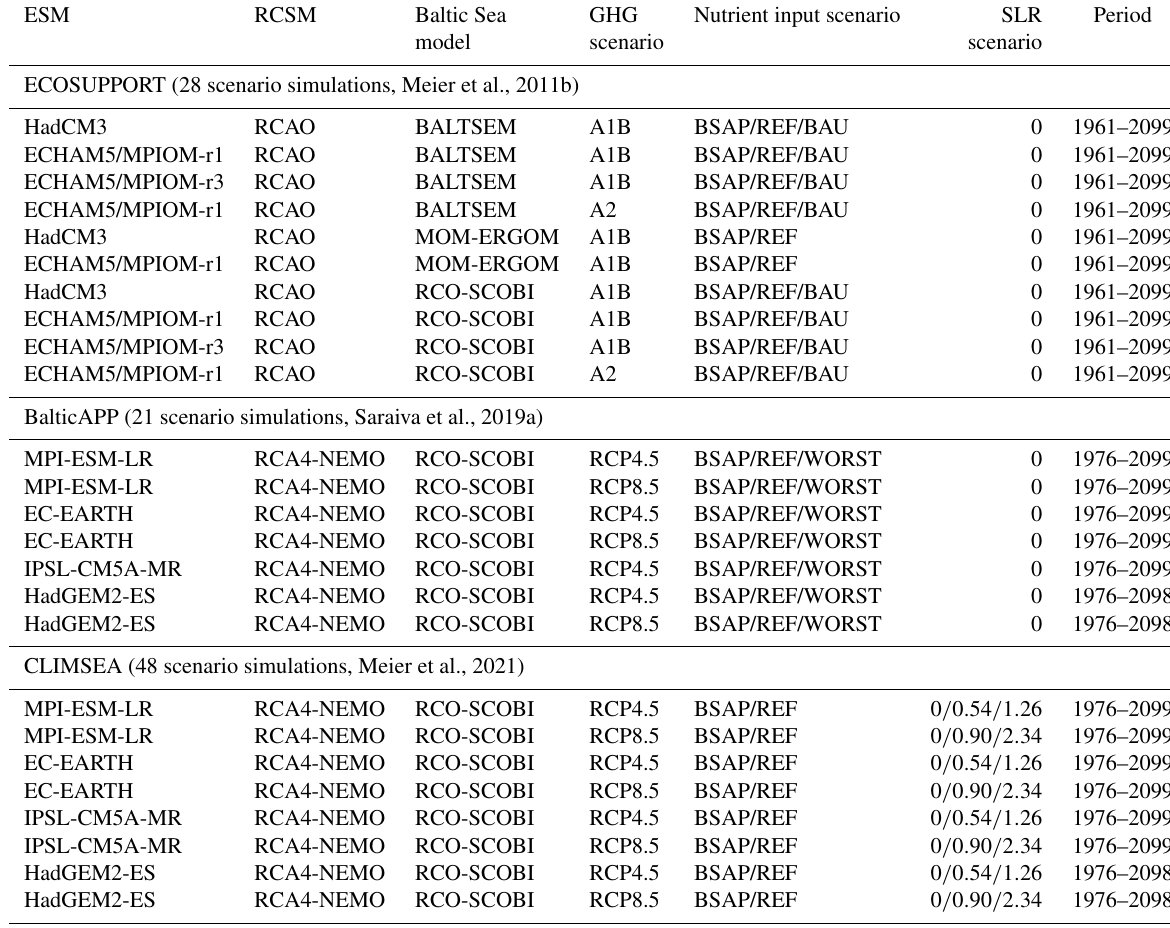
Table 3. List of scenario simulations of three ensembles. From left to right, the columns show the Earth system model (ESM), the regional climate system model (RCSM), the Baltic Sea ecosystem model, the greenhouse gas (GHG) emission or concentration scenario, the nutrient input scenario, the sea level rise (SLR) scenario and the simulation period, including historical and scenario periods. The four nutrient